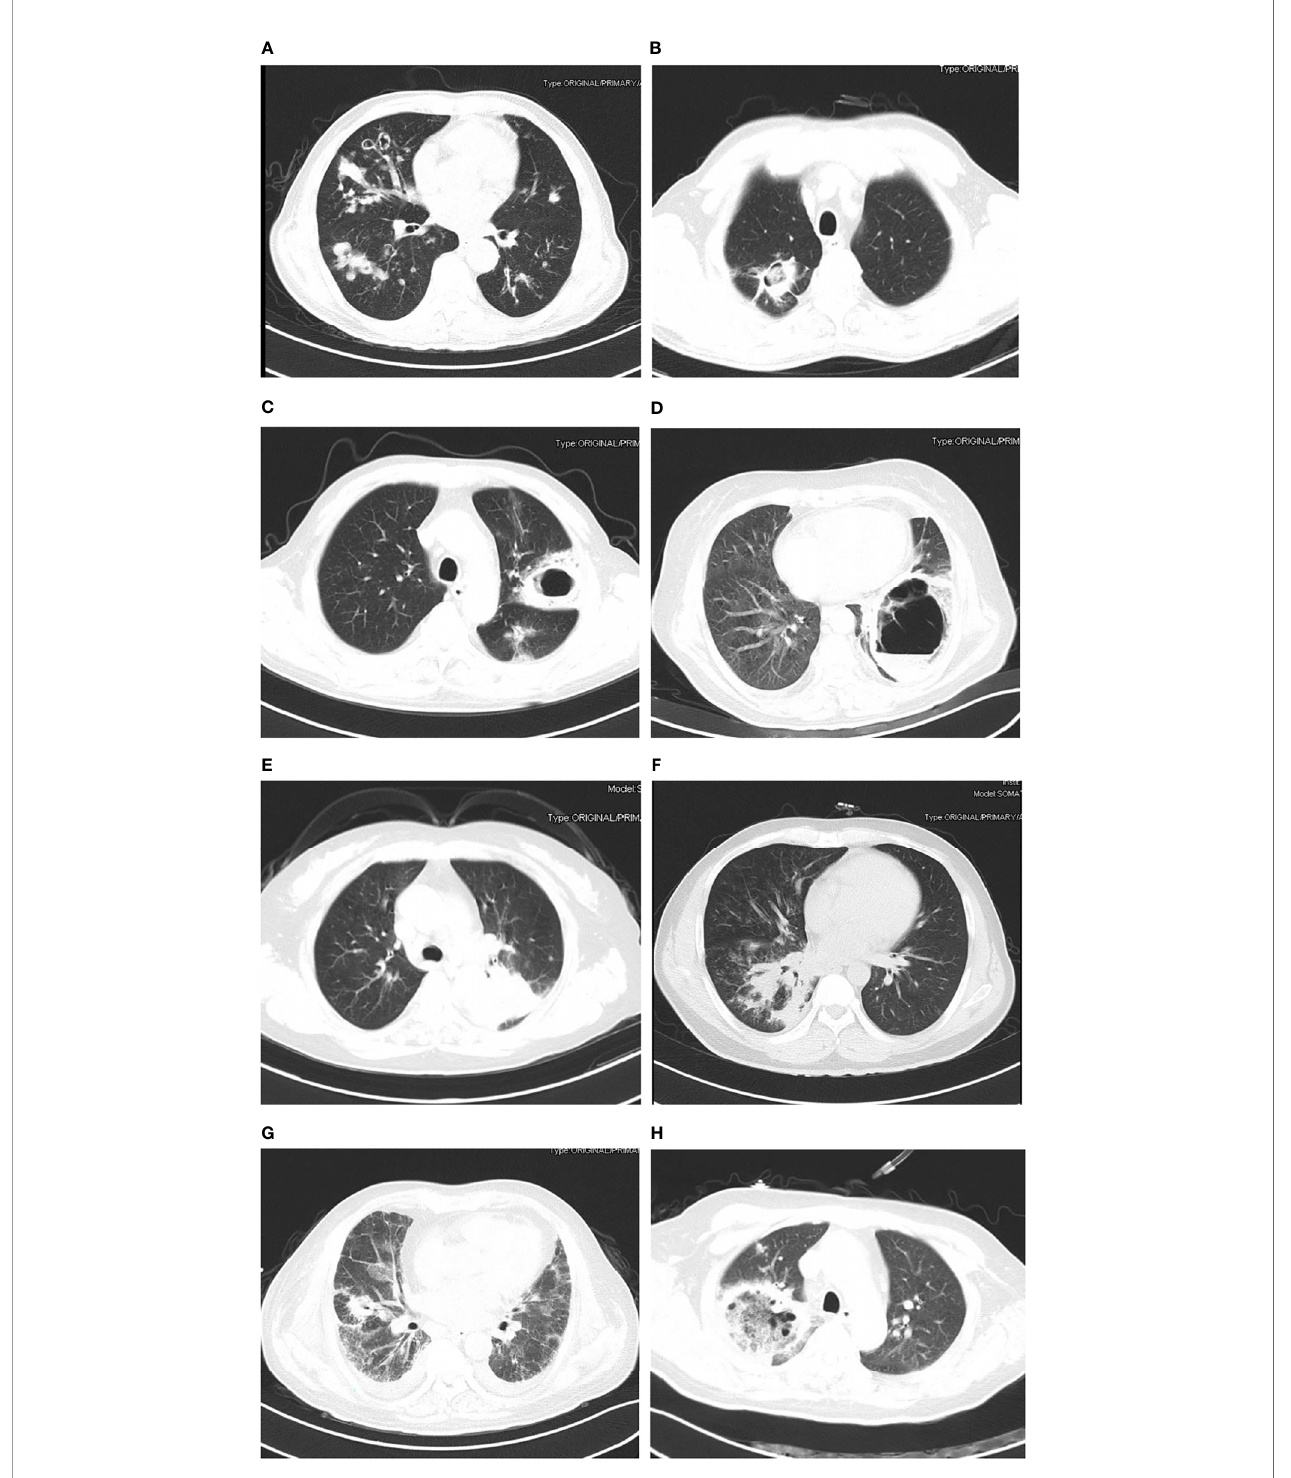
FIGURE 1 | The fi ndings of chest computed tomography of pulmonary mucormycosis (patients with good outcome: A, B ; patients with worse outcome: C – H ). (A) Multiple pleomorphic lesions in both lungs; (B) cavity with muralnodule ( Mucor co-infecting with Aspergillus ); (C) cavity in left lung; (D) thick-walled cavity shadow with gas- fl uid level ( Mucor co-infecting with Klebsiella pneumoniae ); (E) mass shadow in the upper lobe of the left lung; (F) patchy shadow, nodules and consolidation in right lung; (G) cavity and ground-glass opacity; (H) reversed halo